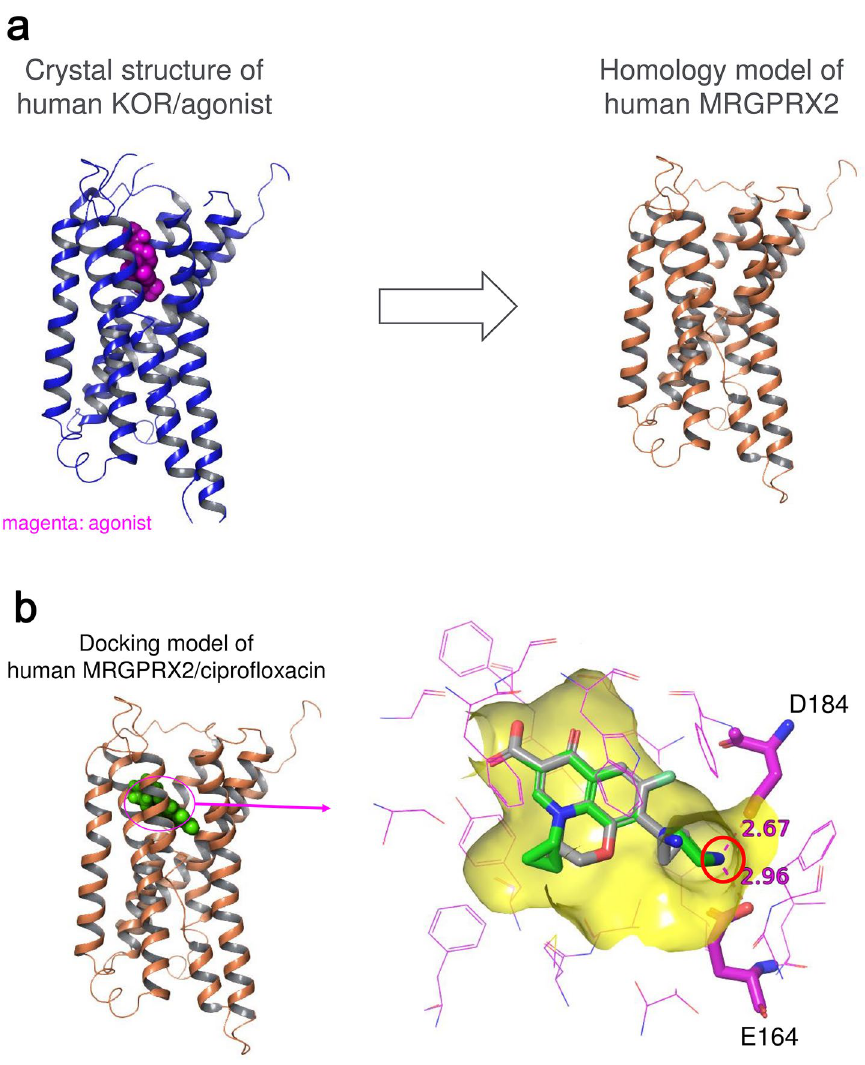
Figure 1. Homology modeling of human MRGPRX2 and docking simulation with fluoroquinolones. ( a ) Homology modeling of human MRGPRX2. A model of human MRGPRX2 was built with Prime version 4.5 using the crystal structure of agonist-bound human kappa opioid receptor (KOR) as a template. ( b ) Docking model of human MRGPRX2 with ciprofloxacin (CPFX, green) or pazufloxacin (PZFX, gray). A basic substituent at the 7 position of CPFX is highlighted by a red circle. The docking study incorporating the induced fit effect was performed with the Induced Fit Docking (IFD) algorithm from Schrödinger. The docking model of PZFX was constructed by superimposition with